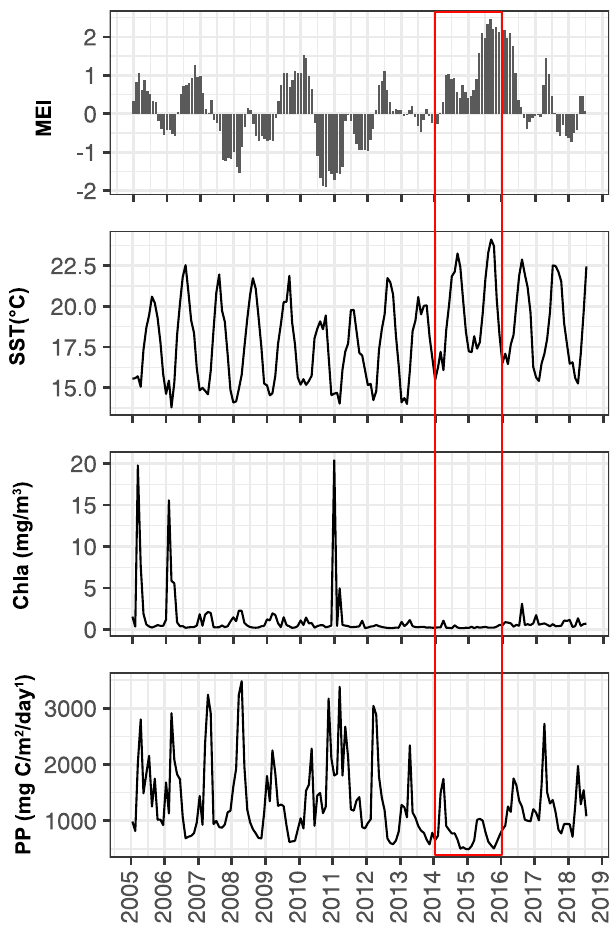
Fig. 1 | Temporal variation of multivariate ENSO index (MEI), sea surface tem- perature (SST), monthly average satellite chlorophyll-a concentration (Chla), and monthly average satellite primary productivity(PP)at theSPOTlocation. MEI index is used to characterize the intensity of the El Niño/Southern Oscillation (ENSO) event; large positive MEI values indicate El Niño conditions, whereas large negative MEI values indicate La Niña conditions. In 2014 – 2015 (red box), probably due to El Niño (MEI>0) and a marine heatwave known as the “ Blob ” , this location experienced reduced productivity and unusually warm temperatures (particularly winters), which also persisted to a lesser extent through the end of the study. Source data are provided as a Source data fi